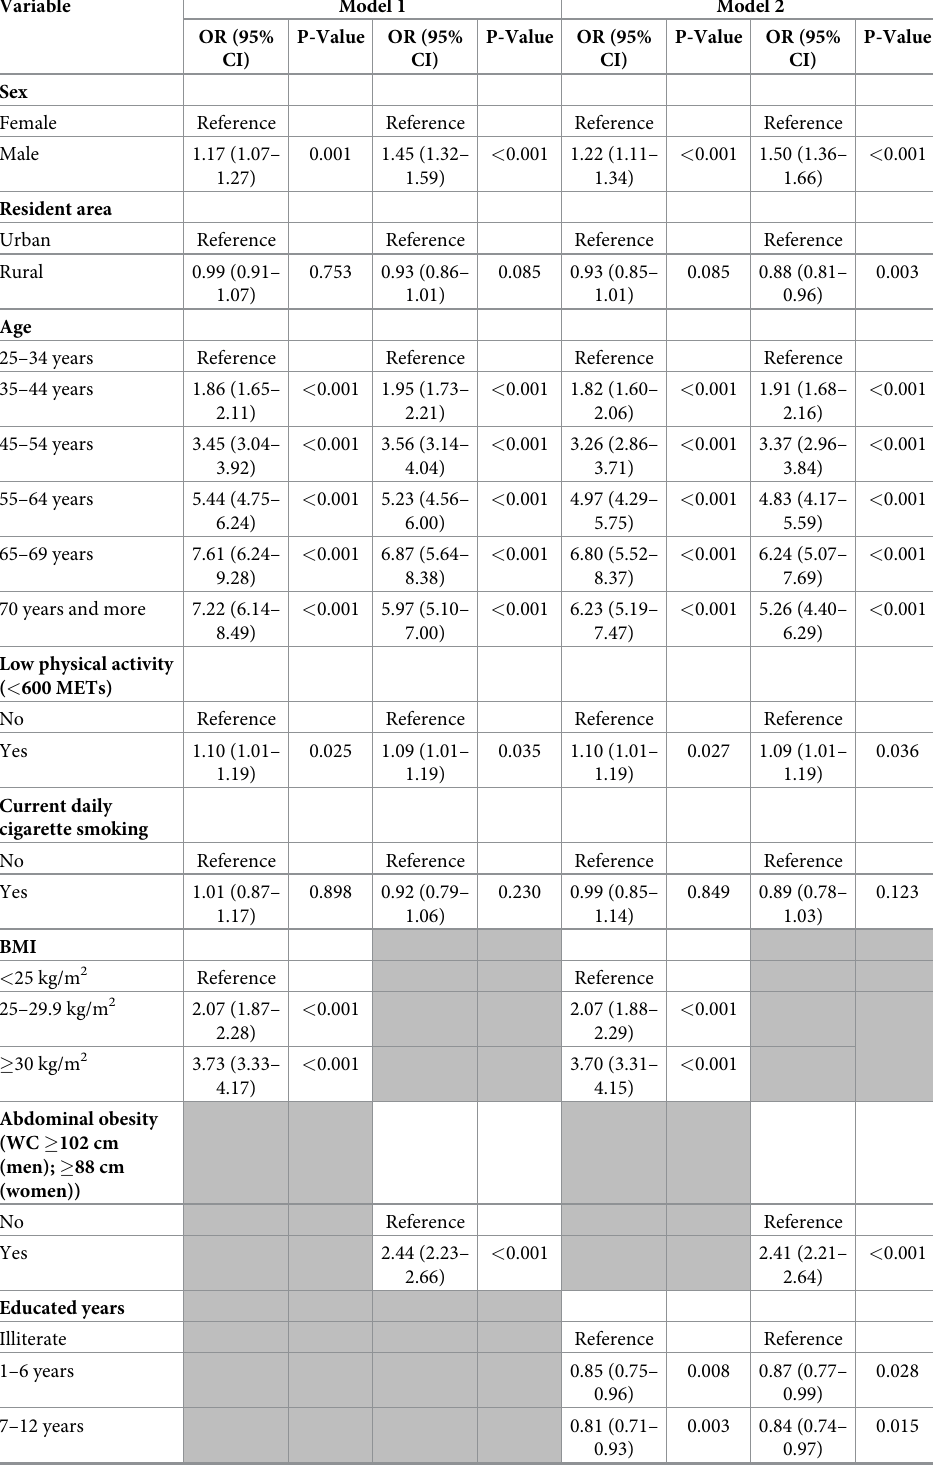
Table 5. Sensitivity analysis to assess the association of different risk factors and risk of being metabolically unhealthy phenotype among the overall Iranian